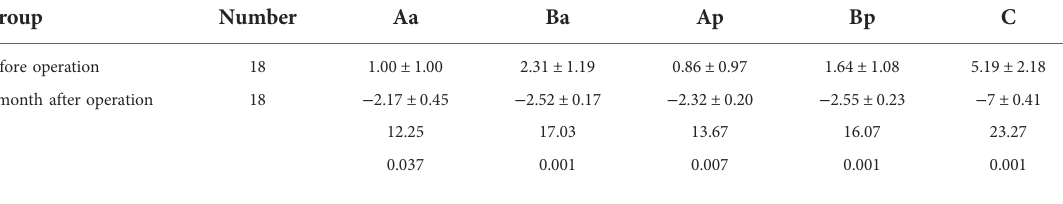
TABLE 4 POP-Q scores before and 6 months after